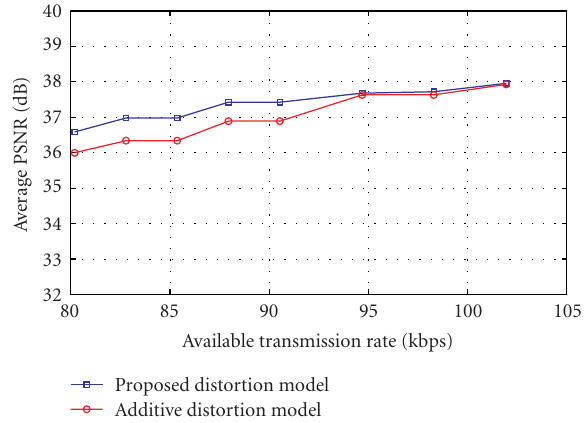
Figure 3: Average PSNR (in dB) as a function of available transmis- sion rate (in kbps) for the “even-loss distribution” algorithm. Com- parison between the proposed and the simplified “additive” distor- tion model for the video sequence Salesman .